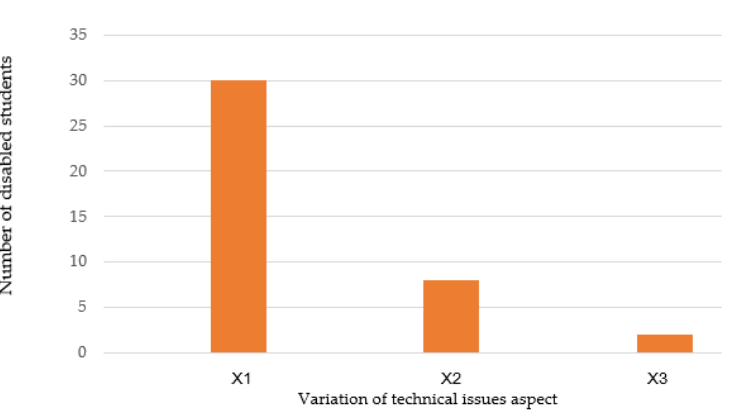
Figure 6. Technical issues of 3D virtual laboratory.